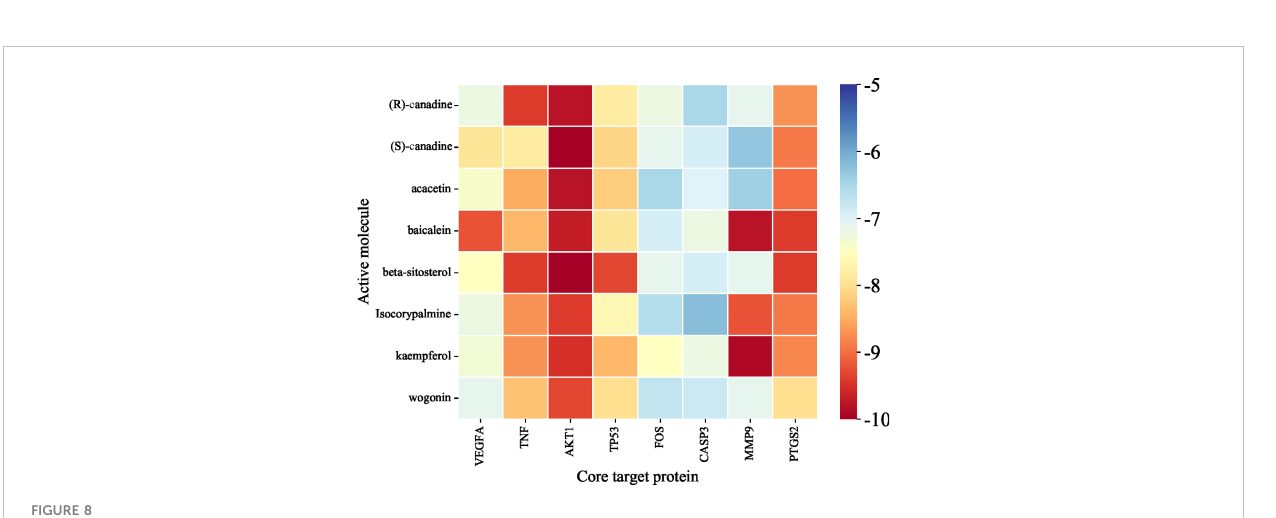
FIGURE 8 Molecular docking heatmap of chemical compositions to targets.